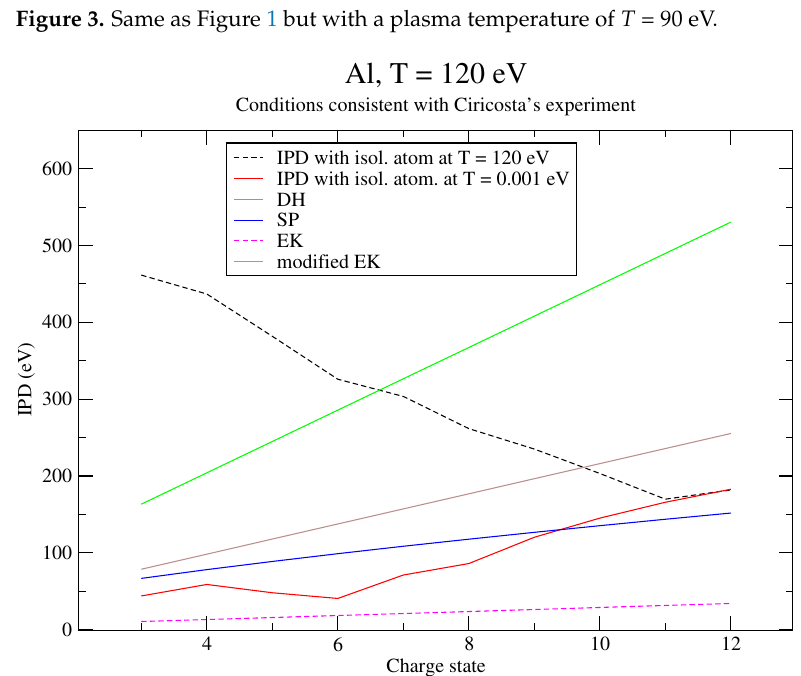
Figure 4. Same as Figure 1 but with a plasma temperature of T = 120